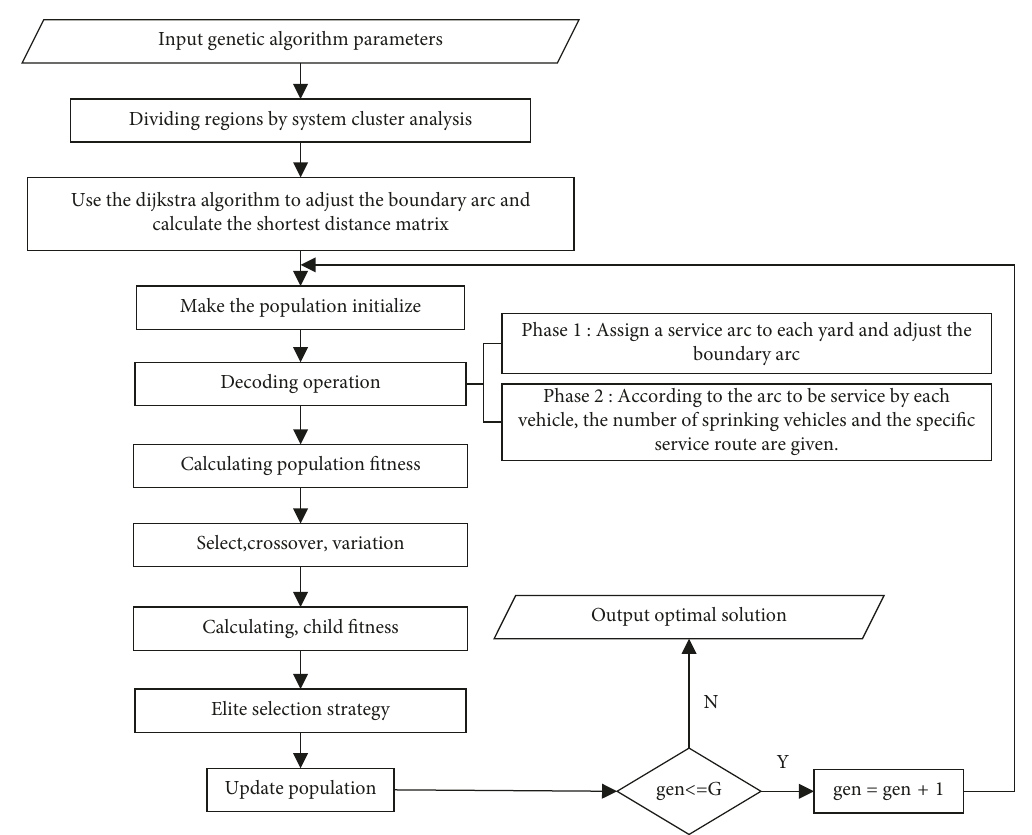
Figure 3: Flow chart of two-stage hybrid genetic